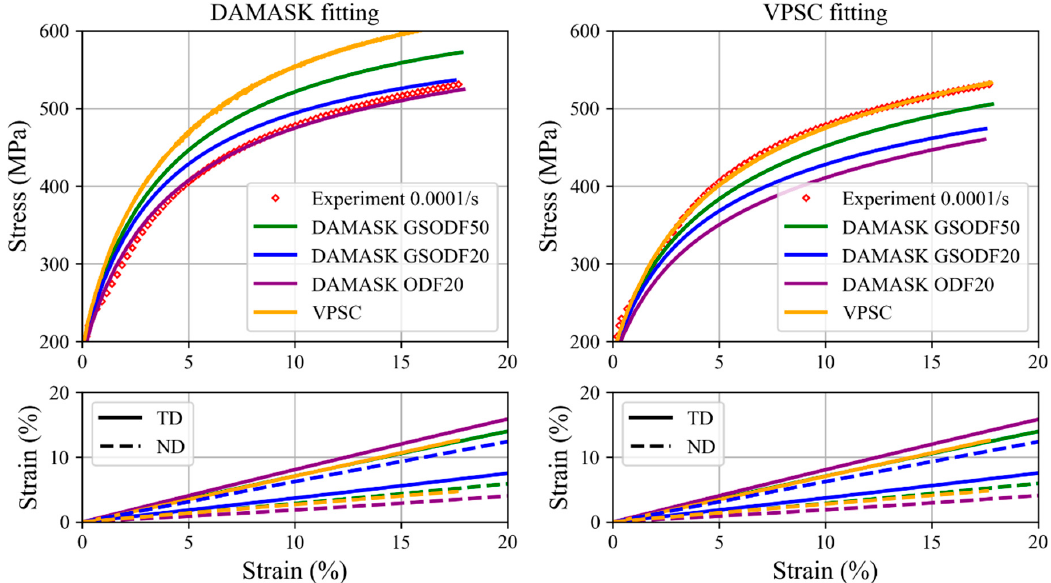
Figure 16. Experimental and simulated tensile test curves and simulated transversal and normal strain resulting from: application of material parameters set obtained after calibration with VPSC and GSODF full texture (at left); and application of material parameter set obtained after calibration with CPFEM and RVE ODF20 (at right).